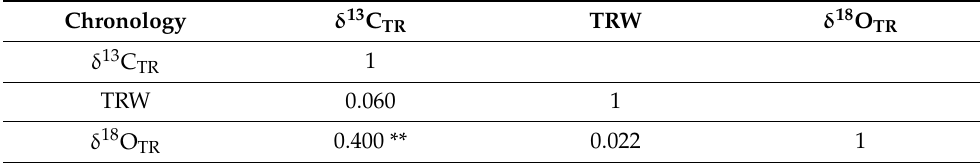
Table 2. Correlation coefficient between tree ‐ ring chronology (TRW), tree ‐ ring δ 13 C ( δ 13 C TR ), and tree ‐ ring δ 18 O ( δ 18 O TR ).